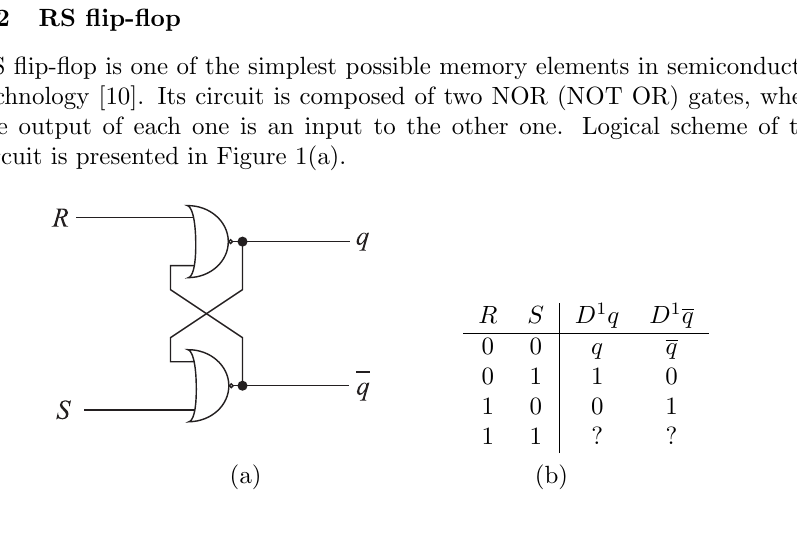
Figure 1. Logical scheme of RS flip-flop is presented in Figure (a) and its behaviour in Figure (b), where R presents Reset input, S Set input, q and q current outputs of the flip-flop and D 1 q in D 1 q outputs of the flip-flop in the next time step. Undefined output value is denoted with